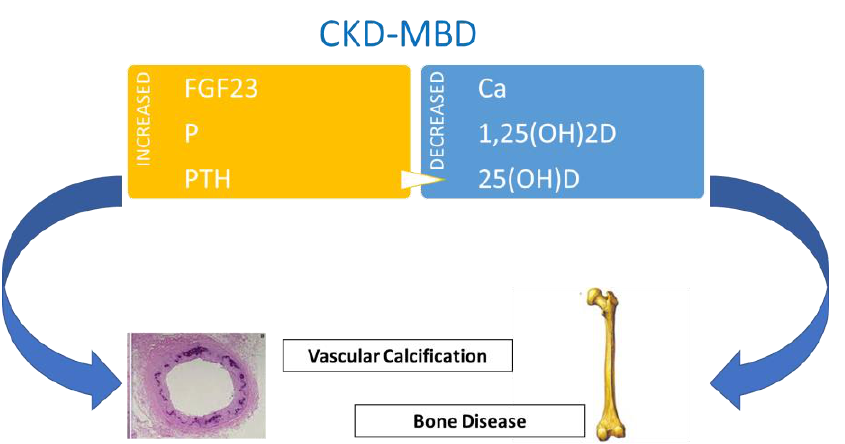
Figure 2. CKD-MBD pathogenesis and its main systemic effects. FGF23, fibroblast growth factor 23; P, phosphorus; PTH, parathyroid hormone; Ca, calcium.